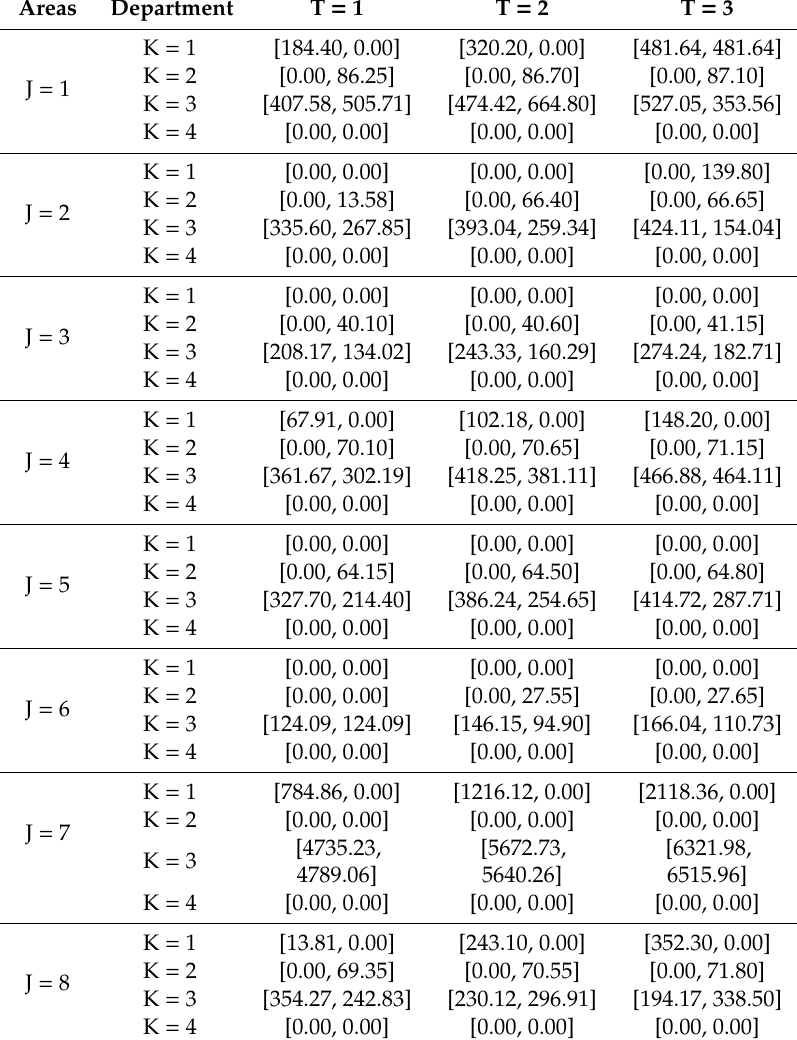
Table 2. The range of reuse water consumption of department k in area j during period t (10 4 m 3 / year).